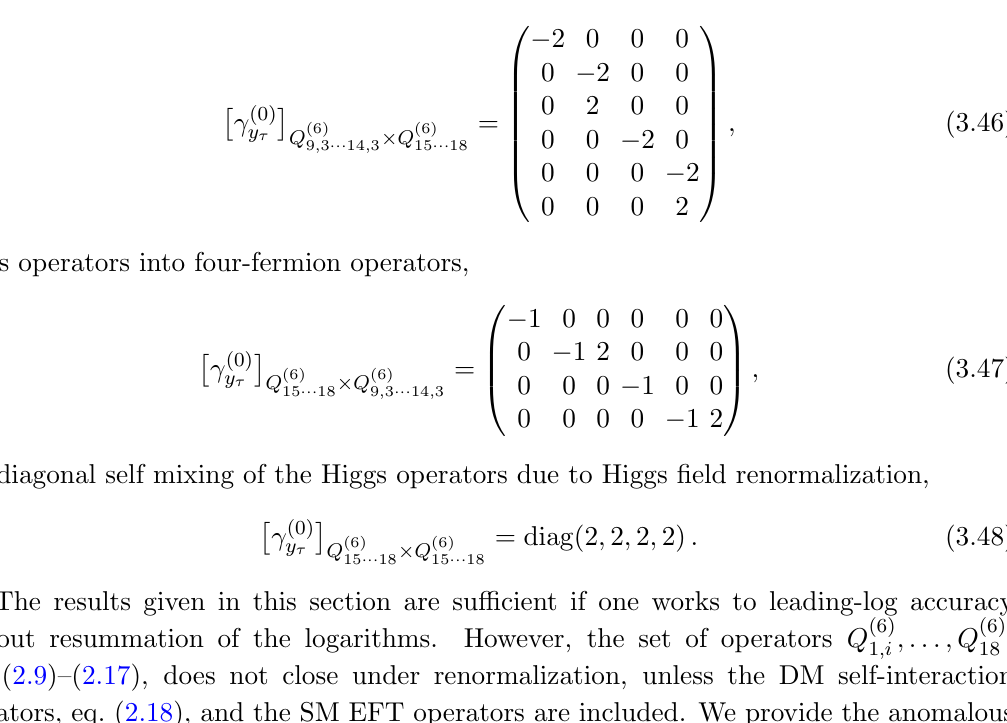
L L and q R (cid:28) R mix DM-lepton and ! !